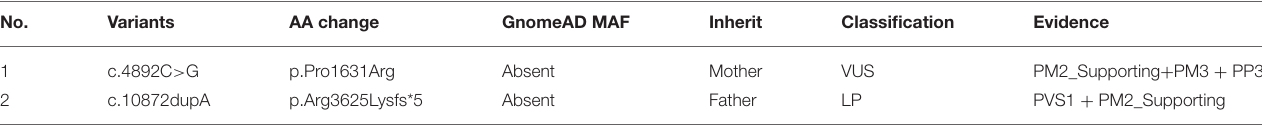
FIGURE 1 | inherited from both the father and mother. + : wildtype; -: variant type. (D) Variant-reported summary. Variants from one patient were labeled together. Variants written in black are those from dead probands. Variants written in green are those from probands who survived. Variants written in red are those discovered in our patient. TABLE 1 | Analysis of variants detected in KIAA1109 (NM_015312.3).